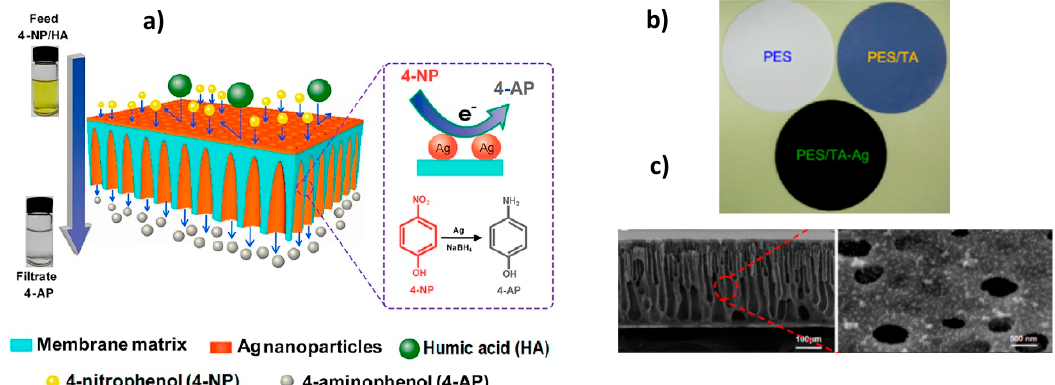
Figure 11. Scheme of membrane flow-through reactor for simultaneous catalysis and separation ( a ), PES, PES/TA and PES/TA-AgNPs membranes ( b ), cross-section of PES/TA-AgNPs membrane ( c ). (Reprinted from [52]).